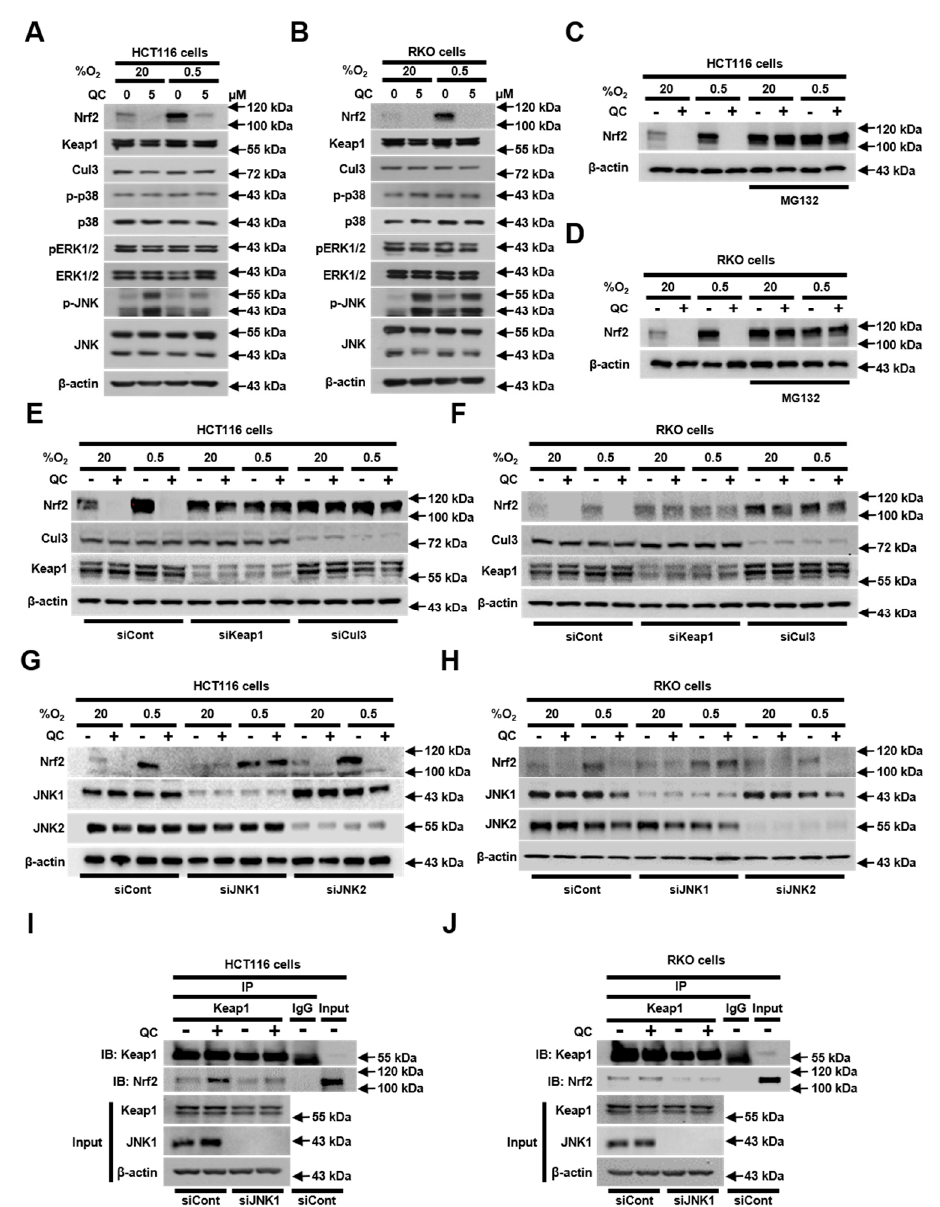
Figure 4. JNK1 activation is required for the QC-induced degradation of Nrf2 protein. ( A,B ) E ff ect of QC on the expression of Nrf2, Keap1, Cul3, p-p38, p38, pERK1 / 2 (phospho extracellular signal-regulated kinases), ERK1 / 2, p-JNK, JNK, and β -actin in HCT116 cells ( A ) and RKO cells ( B ) under normoxic and hypoxic conditions. ( C,D ) E ff ect of QC on the proteasome-mediated degradation of Nrf2 in HCT116 cells ( C ) and RKO cells ( D ) under normoxic and hypoxic conditions. ( E,F ) E ff ect of QC on Keap1 / Cul3-dependent degradation of Nrf2 in HCT116 cells ( E ) and RKO cells ( F ) under normoxic and hypoxic conditions. ( G,H ) E ff ect of JNK1 activation on QC-induced inhibition of Nrf2 in HCT116 cells ( G ) and RKO cells ( H ) under normoxic and hypoxic conditions. ( I,J ) E ff ect of QC on the interaction between Nrf2 and Keap1 in HCT116 cells ( I ) and RKO cells ( J ) under hypoxic conditions. Representative images of Nrf2, Keap1, Cul3, p-p38, p38, pERK1 / 2, ERK1 / 2, pJNK, JNK, and β -actin were detected by immunoblot. Representative images of immunoblots for each protein were obtained using the same sample on di ff erent gels after a single experiment.